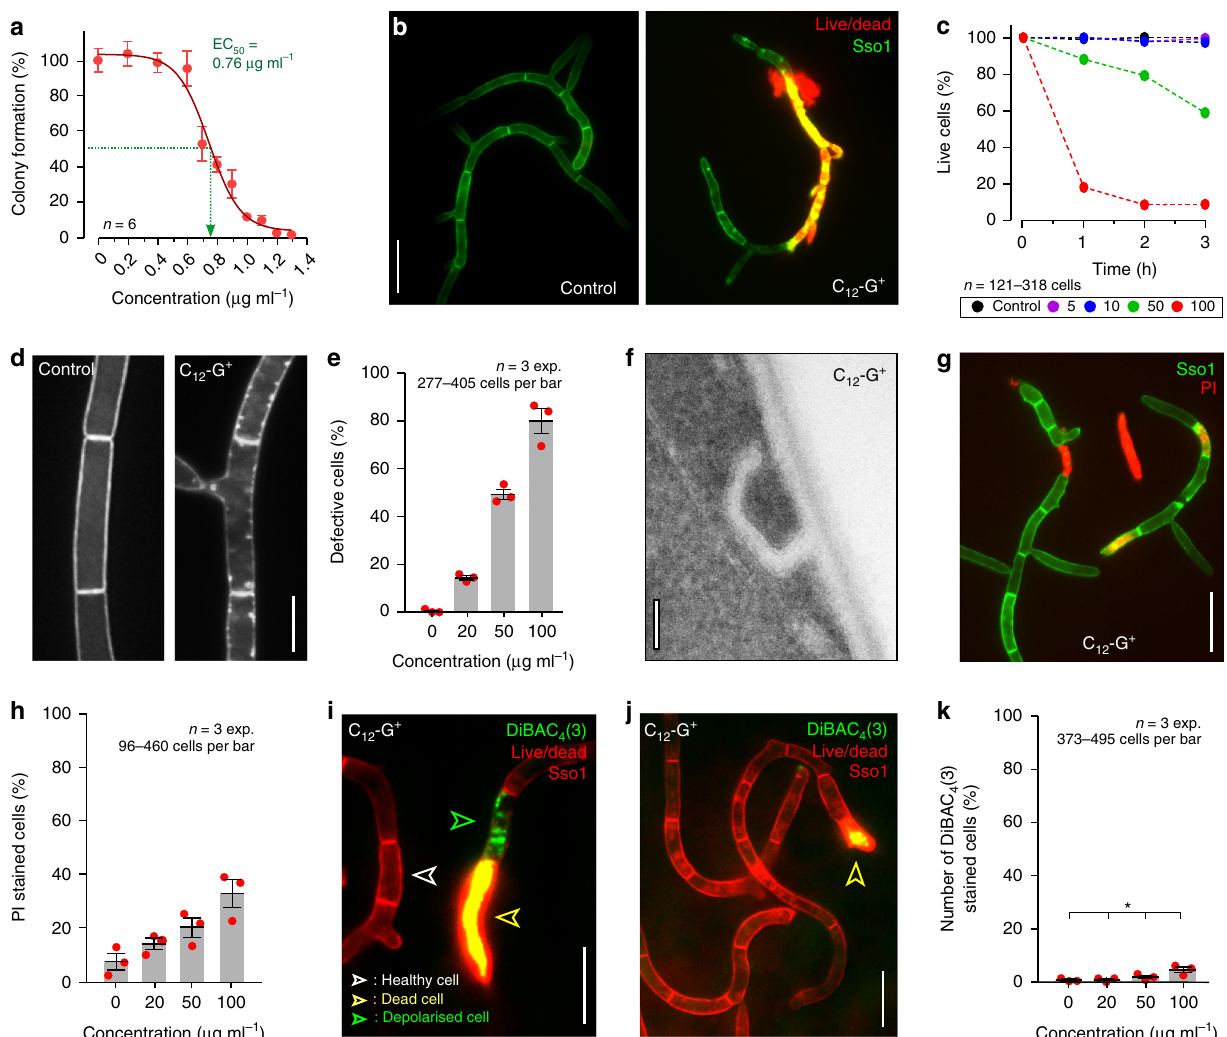
Fig. 1 The effect of C 12 -G + on Z. tritici plasma membrane. a Colony formation of Z. tritici after 5 days growth on agar plates, supplemented with increasing amounts of C 12 -G + . Green dotted line indicates EC 50 concentration. b Live/dead staining of Z. tritici cells, expressing plasma membrane marker GFP-Sso1, after 3 h treatment with C 12 -G + . Dead cells are either yellow or red. Scale bar = 15 µ m. c Survival curves of Z. tritici cells grown in C 12 -G + -supplemented liquid medium. Scale bar = 5 µ m. d Plasma membrane, labeled with GFP-Sso1, in C 12 -G + and solvent-only-treated cells (Control) of Z. tritici . C 12 -G + induces accumulation of the fl uorescent marker at the cell periphery. e Bar chart showing the increase of cells with GSP-Sso1 accumulations with increasing concentrations of C 12 -G + . f Electron micrographs of plasma membrane invaginations, caused by C 12 -G + treatment in Z. tritici . See also Supplementary Fig. 2. Scale bar = 0.1 µ m. g Effect of C 12 -G + on plasma membrane permeability to the small molecule propidium iodide. Note that propidium iodide has a similar size to ATP. Scale bar = 15 µ m. h Bar chart showing number of cells that contain propidium iodide at various concentrations of C 12 -G + . i Effect of C 12 -G + on plasma membrane permeability to ions, indicated by membrane depolarization, as monitored with the voltage-sensitive fl uorescent dye DiBAC 4 (3) (green). Cells express mCherry-Sso1 (red at cell periphery) and were counter-stained with live/dead dye (red). Live cells only show red fl uorescence in the plasma membrane (white open arrow), dead cells combine cytoplasmic red and green fl uorescence (yellow open arrow); depolarised cells combined a faint peripheral staining in red and cytoplasmic green fl uorescence (green open arrowhead). Only these cells were considered in the subsequent quantitative analysis. Scale bar = 10 µ m. j Z. tritici cells, expressing mCherry-Sso1 (red, peripheral), incubated with C 12 -G + and co-stained with live/dead stain and DiBAC 4 (3). Only dead cells take up the voltage-sensitive dye (yellow open arrowhead), demonstrating that the MALC is not perforating the plasma membrane. Scale bar = 10 µ m. k Bar chart showing number of cells which are DiBAC 4 (3)-positive at various concentrations of C 12 -G + . Note that only green- fl uorescent cells that did not show live/dead dye uptake are included. Values ( a , e , h , k ) are shown as mean ± standard error of the mean (SEM), sample size n is indicated in each panel. Red dots represent data points. Non-linear regression curve ( a ) was calculated as dose- response inhibition (four parameters) in Prism5. In k , one-way ANOVA testing was performed; * P value of 0.0107. See Supplementary Table 7 for experimental conditions. All source data are provided as a Source Data fi analysis by co-staining with a live/dead stain. The living cells membrane (Fig. 1j, k). Thus, we conclude that disruption of the showed red- fl uorescent plasma membranes, but only took up plasma membrane is not the primary MoA of C 12 -G + . DiBAC 4 (3) upon cell depolarization (Fig. 1i). Even at 100 µg ml − 1 C 12 -G + , only few cells showed green DiBAC 4 (3) fl uorescence, suggesting that the MALC has minor effects on the plasma tion . Next, we tested the alternative hypothesis that lipophilic